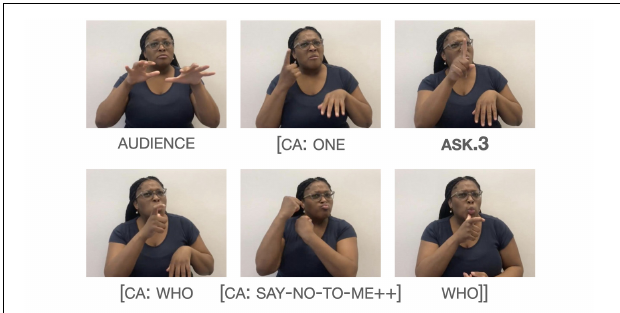
does not quote or even paraphrase what the questions were.